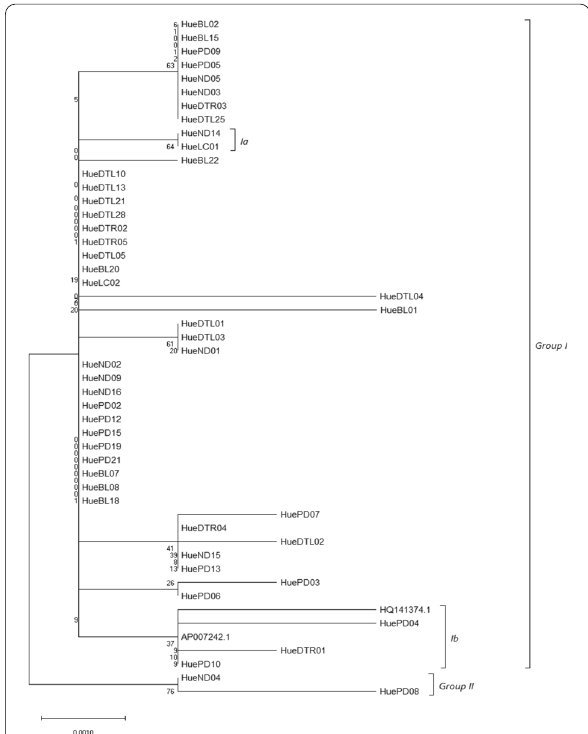
Fig. 4 Maximum parsimony phylogenetic tree based on the COI nucleotide